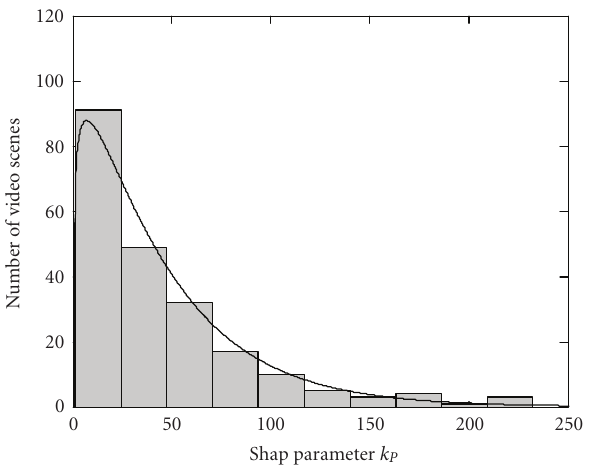
Figure 3: Histogram of the relative complexity X P over video scenes that is fitted to a Gamma